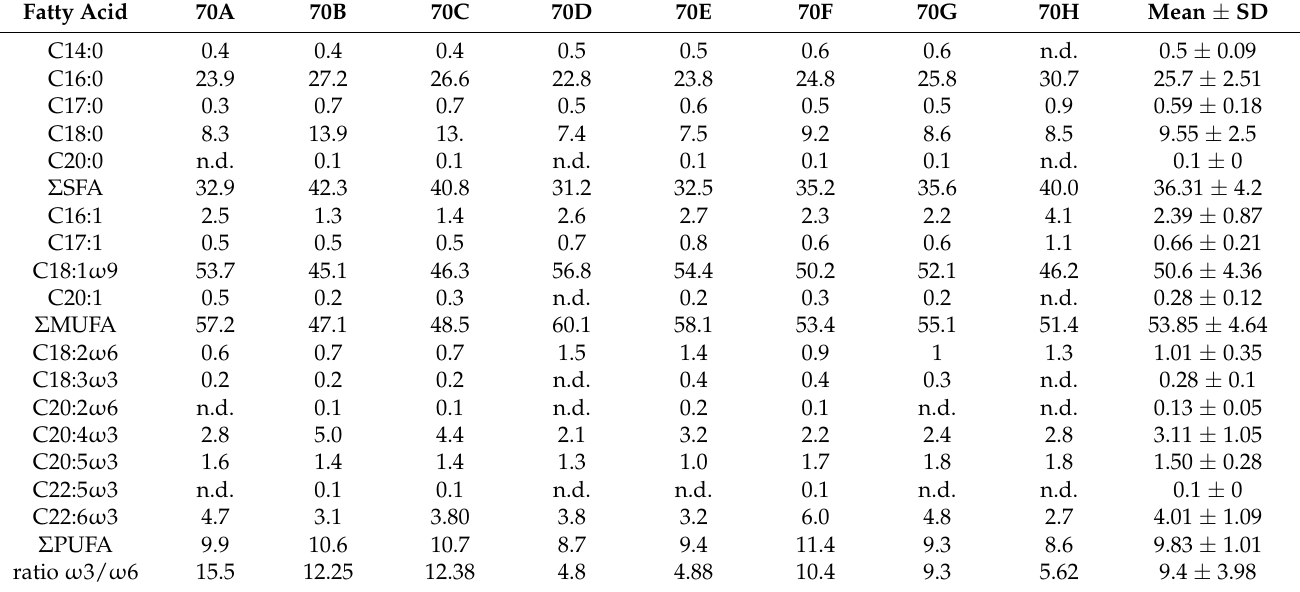
Table 2. FAs composition of the stomach oil samples collected at day 70 (expressed as %). n.d. = not